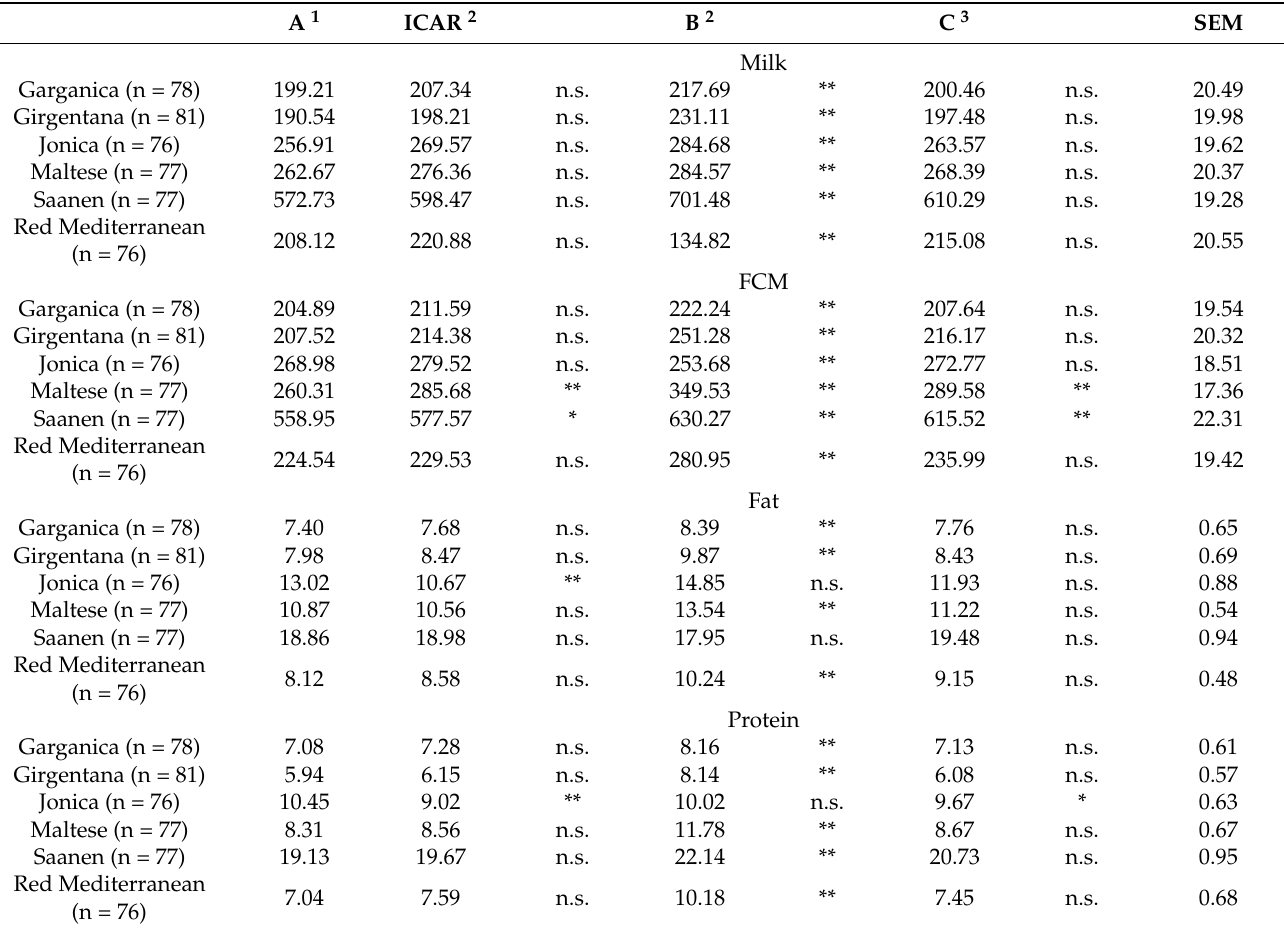
Table 3. Differences between the total yield (milk, FCM, fat, and proteins) estimated by Wood’s model application on 14 test-day milk recordings and other calculation methods applied. Results are expressed as least square means and standard error of the mean